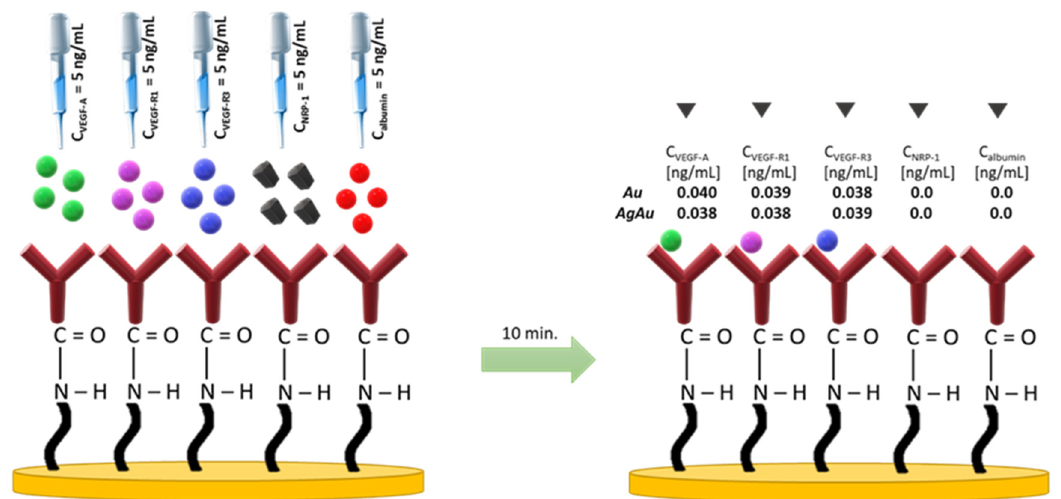
Figure A2. Schematic diagram of interaction of the interferent with the antibody. Ligand concentra- tion was 20 ng/mL, pH = 7.40.